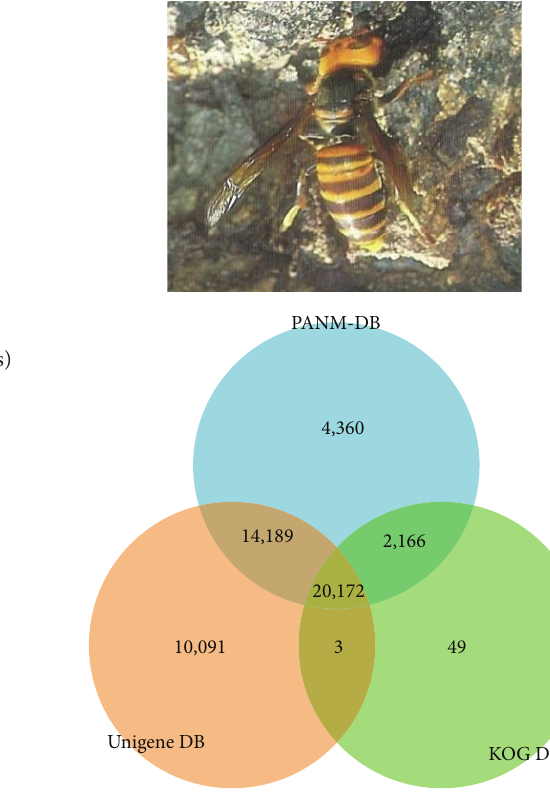
Figure 1: Sequence annotation of unigenes obtained from V. mandarinia transcriptome assembly and clustering. A three-way Venn diagram plot shows the unique and overlapped transcripts from unigene annotation hits (BLASTX; 𝐸 -value ≤ 1𝐸 − 5 ) against PANM-DB, Unigene, and KOG databases,